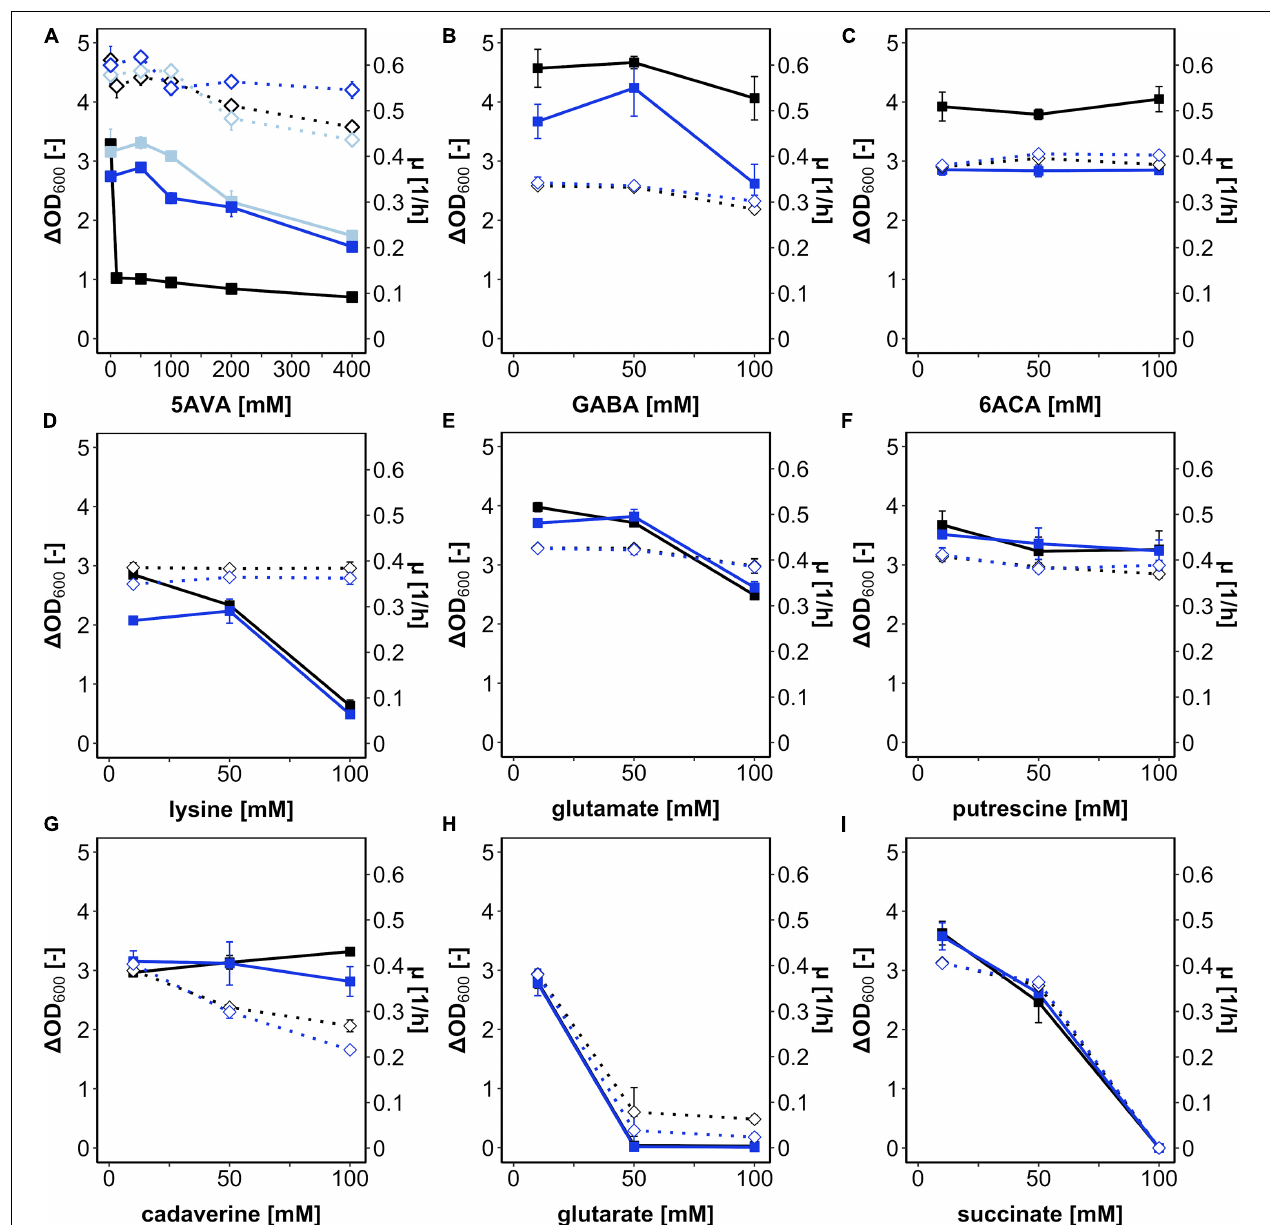
FIGURE 1 | Growth of B. methanolicus in the presence of 5AVA (A) , GABA (B) , 6ACA (C) , L -lysine (D) , L -glutamate (E) , putrescine (F) , cadaverine (G) , glutarate (H) , and succinate (I) . B. methanolicus WT (black), AVA6 (light blue; A ), and AVA10 (blue) were cultivated in MVcMY medium supplemented with 0, 10, 50, 100, 200,